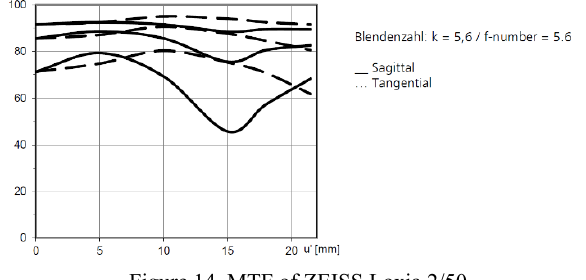
Figure 14. MTF of ZEISS Loxia 2/50 In order to investigate an impact of a degradation of resolution near to outer edges, we created two types of orthoimages by SR- O using a square wave function as a PSF and CS as an interpolation method. Let 𝑅 be a radial distance from the image centre on a focal plane. One is orthoimages created from images where a photographed ROI locates inside the circle of 𝑅 (cid:3404) 18𝑚𝑚 , and the other is orthoimages created from images where a photographed ROI locates inside the circle of 𝑅 (cid:3404) 12𝑚𝑚 . Figure 15 shows three orthoimages by SR-O: (b) using all 40 images, (c) 27 images where a photographed ROI locates inside the circle of 𝑅 (cid:3404) 18𝑚𝑚 , and (d) using 19 images where a photographed ROI locates inside the circle of 𝑅 (cid:3404) 12𝑚𝑚 .